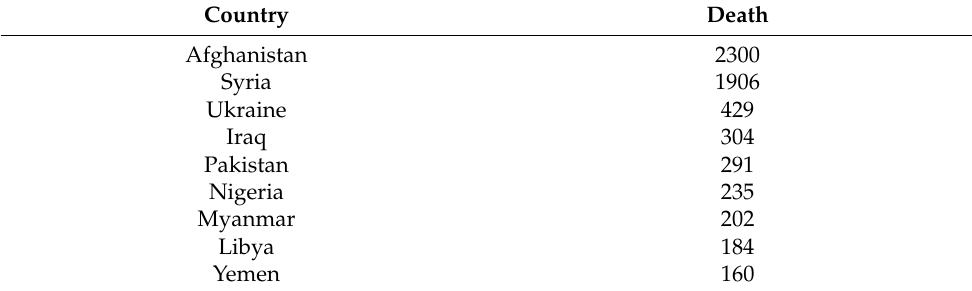
Table 1. Land mine casualties in 2017. Country